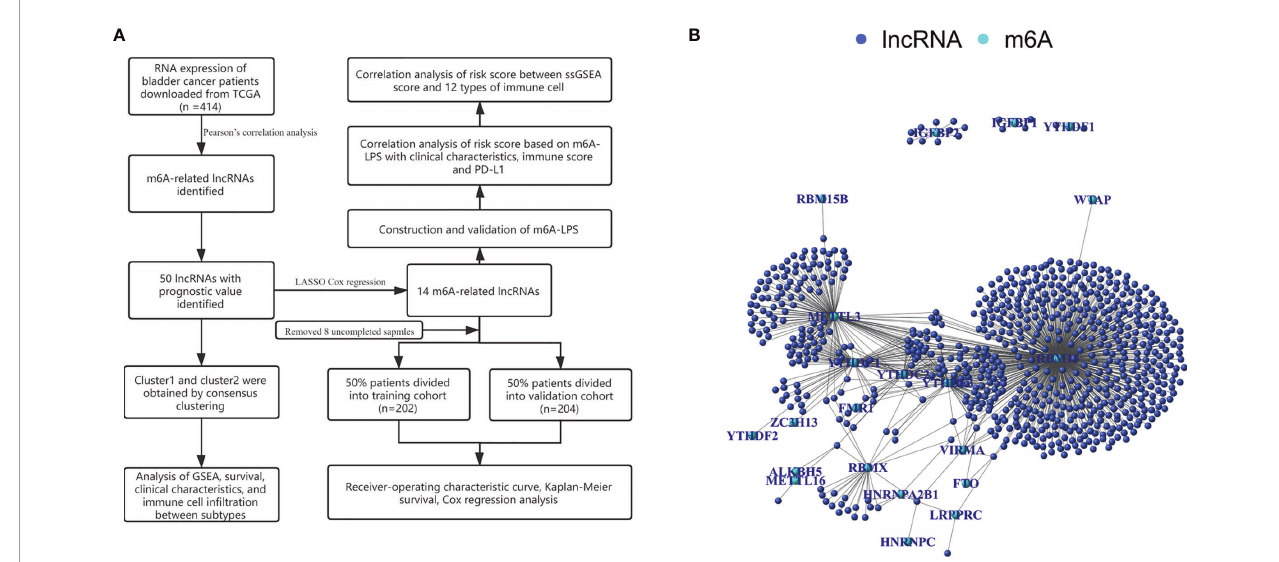
FIGURE 1 | (A) Research fl ow chart. (B) The coexpression network of m6A-related genes and m6A-related